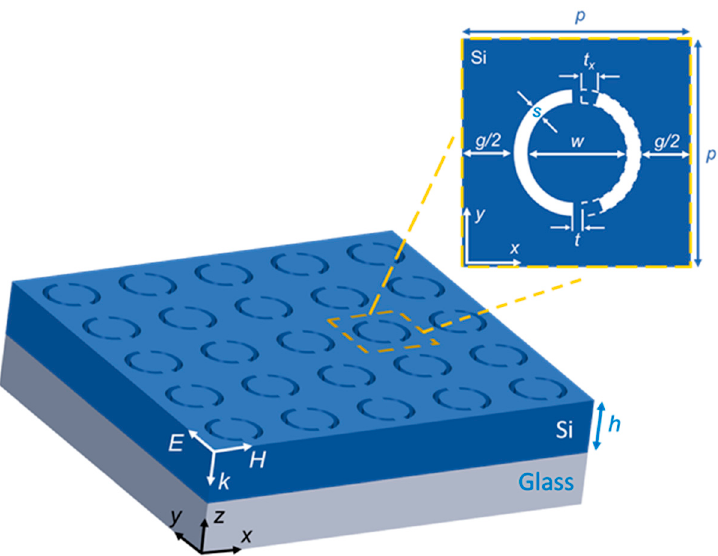
Figure 1. A three-dimensional schematic illustration of the CSRR metasurface. In a silicon layer with a thickness of h , the periodic split rings are etched. The unit cell (marked by a yellow dashed square) is shown in the inset.